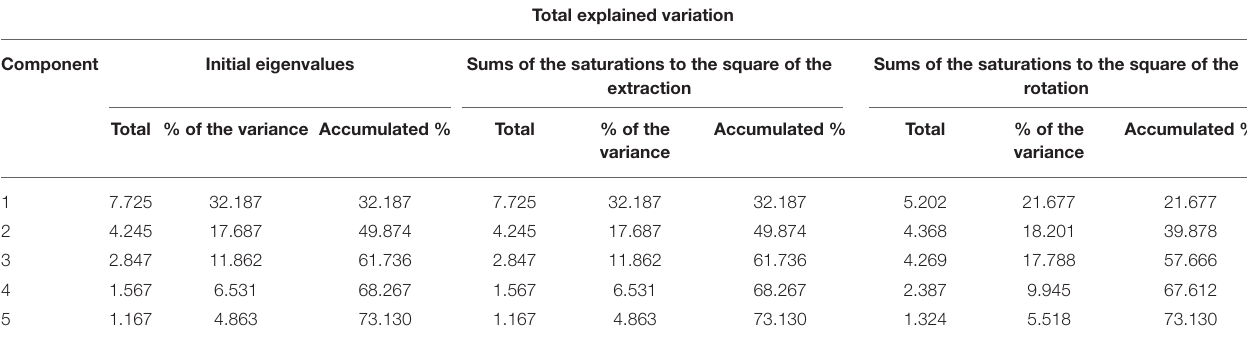
TABLE 3 | Principal component matrix—analysis of the principal